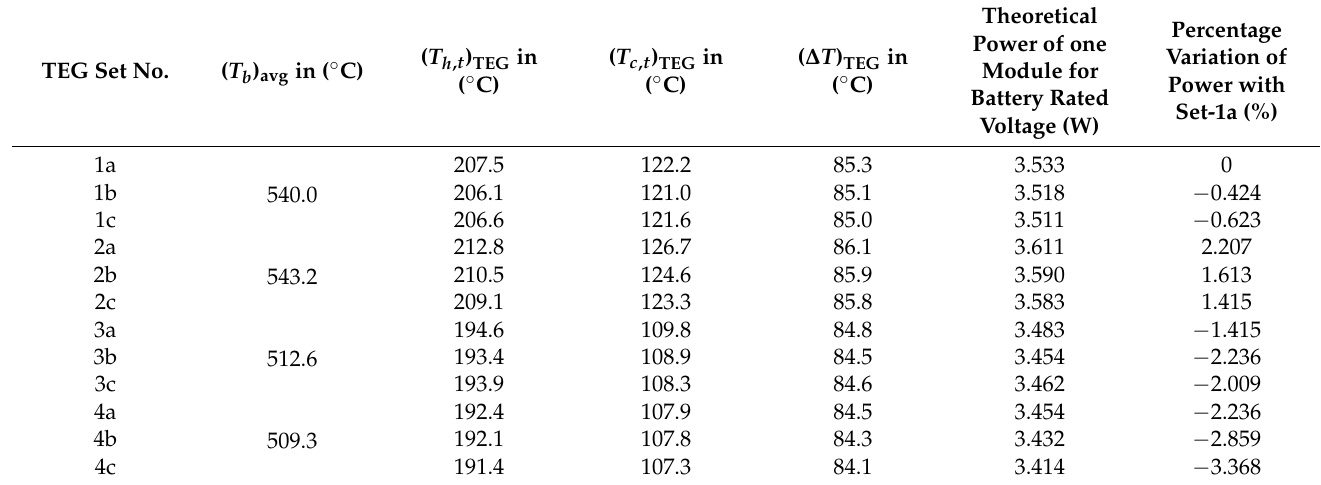
Table 3. Temperatures of various sets of TEG systems and corresponding theoretical power of one module.